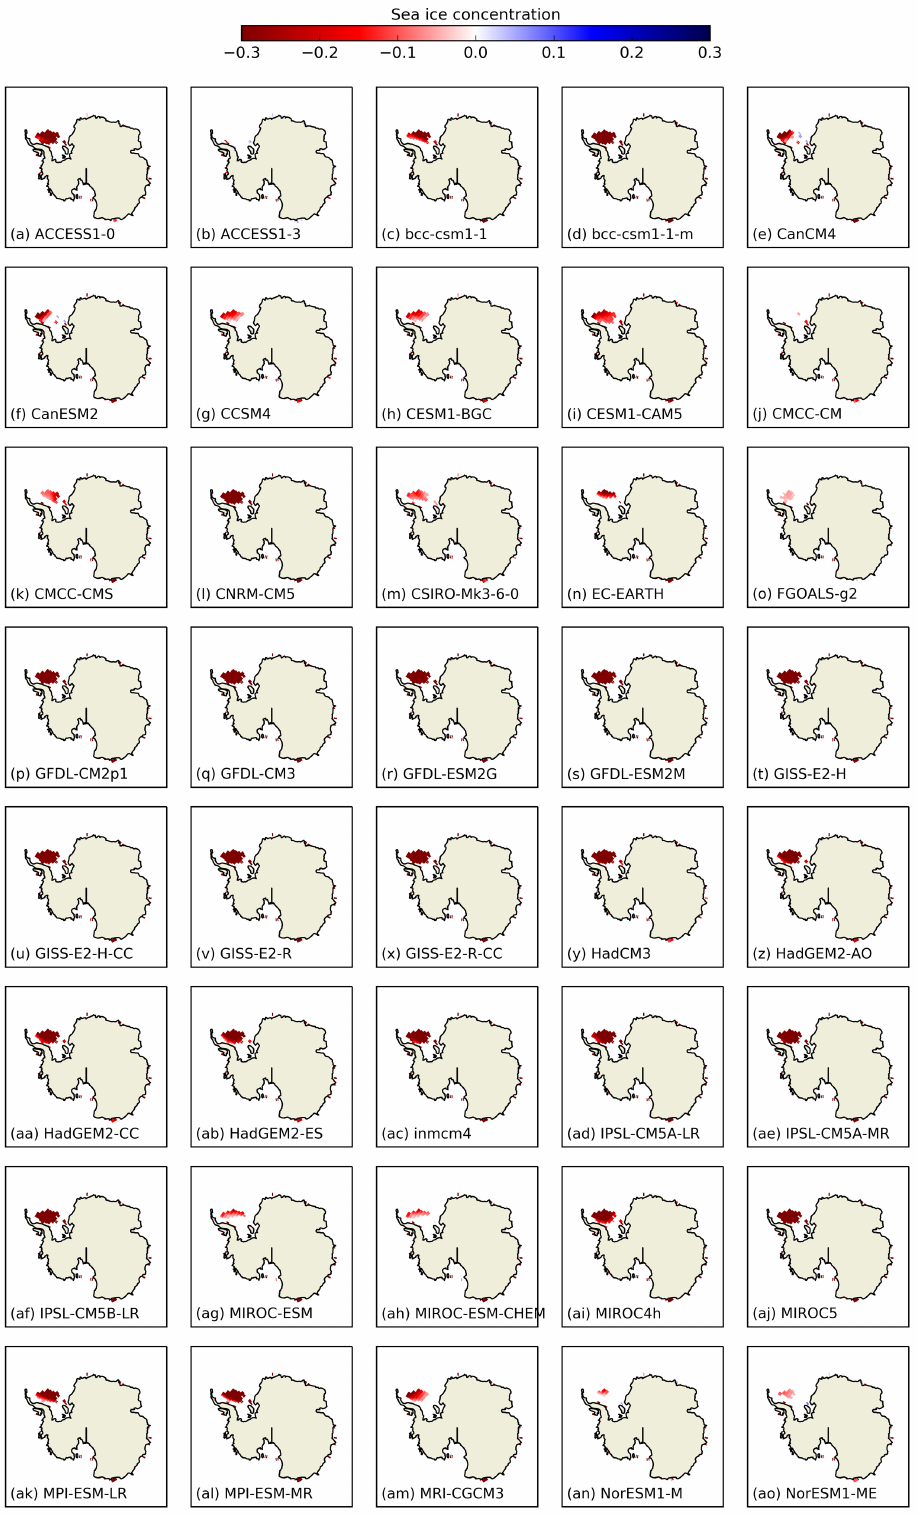
Figure 10. Simulation minus observed ASI-SSMI sea ice concentration for DJF 1992–2014 for each CMIP5 model, where only grid cells with observational mean sea ice concentration is ≥ 90% are considered. Differences are only shown if they are statistically different according to a Student’s t test over 1992–2014 ( p <